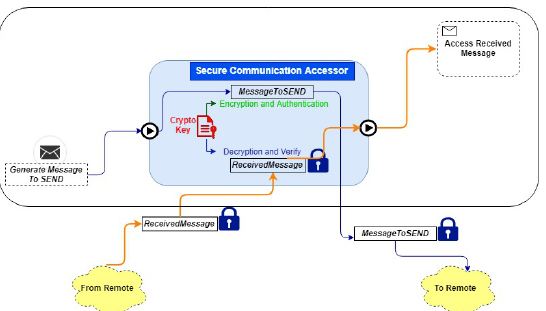
Figure 3. Local authorization service among IoT entity and Cluster Head (CH) nodes for secure